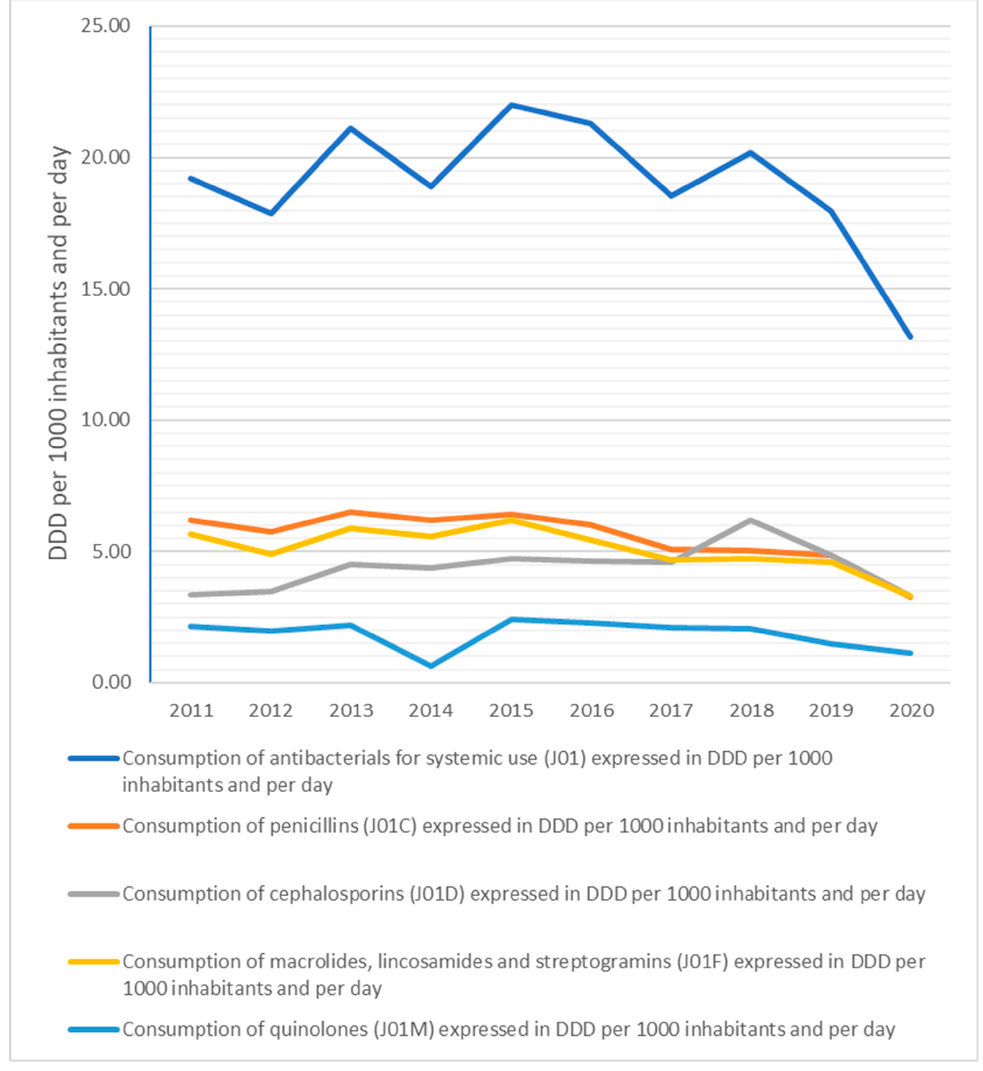
Figure 5. Quality indicators related to the consumption of antibiotics in the community from 2011 to 2020. Consumption of beta-lactamase-sensitive penicillins, expressed as a percentage of the total consumption of antibacterials for systemic use, decreased from 8.4% in 2011 to 4.2% in 2020. Consumption of the combination of penicillins, including beta-lactamase inhibi- tor, expressed as a percentage of the total consumption of antibacterials for systemic use, increased from 16.2% in 2011 to 17.9% in 2020. Consumption of third- and fourth-genera- tion cephalosporins, expressed as the percentage of the total consumption of antibacterials